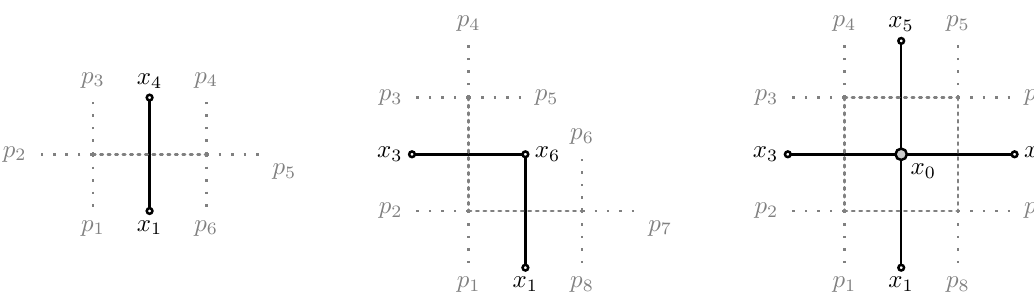
Figure 16 . Momentum space representation and dual space representation of three simple ampli- tudes in bi-scalar (cid:31) FT 4 . All momenta are taken to be